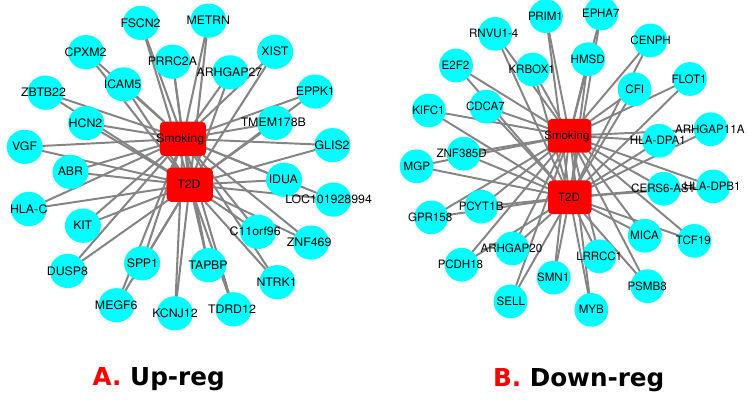
Figure 3. Upregulated and downregulated genes between T2D patients and smokers are represented